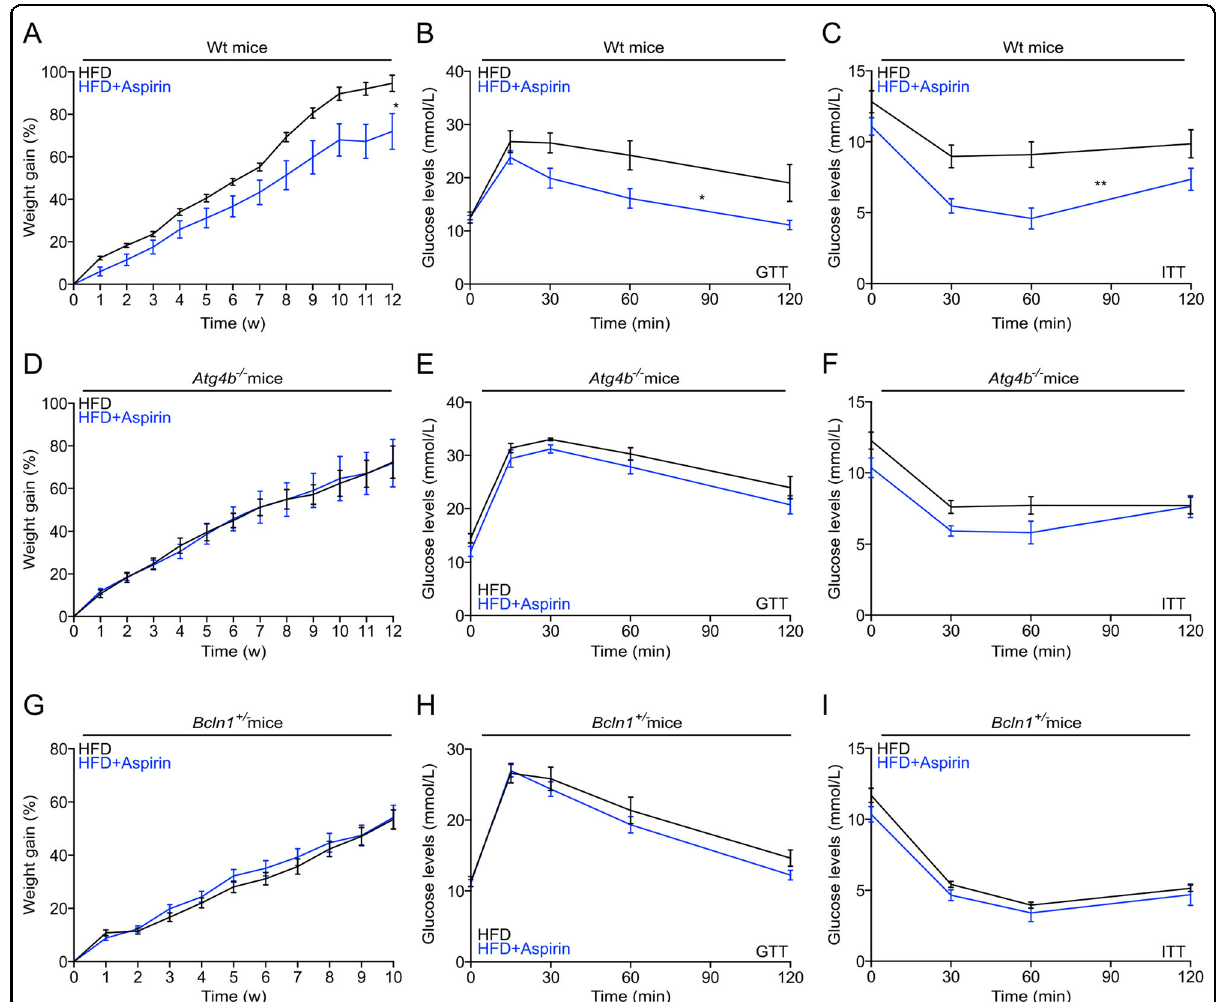
Fig. 4 Autophagy-dependent effects of aspirin on weight gain in high-fat treated mice. a , d , g Male mice with the indicated genotypes (WT, Atg4b − / − or Bcln1 + / − ) received high-fat diet (HFD) (WT mice: n = 10 mice/group; Atg4b − / − mice: Ctrl = 8 and aspirin = 9 mice; Bcln1 + / − mice: Ctrl = 17 and aspirin = 20 mice) for at least 10 weeks in presence, or not, of daily gavage aspirin administration (100 mg/kg in EBSS). Body weight was monitored weekly, and glucose ( b , e , h ) or insulin ( c , f , i ) tolerance tests were performed after 6 – 11 weeks of treatment (WT mice: GTT Ctrl = 7 and aspirin = 9 mice, ITT Ctrl = 7 and aspirin = 10 mice; Atg4b − / − mice: GTT and ITT Ctrl = 7 and aspirin = 9 mice; Bcln1 + / − mice: GTT Ctrl = 14 and aspirin = 16 mice, ITT Ctrl = 14 and aspirin = 14 mice). For statistical analysis, longitudinal statistical comparisons for mice weight gain, were performed by Wald test ( a , d , g ) (* p < 0.05); p values were determined by two-tailed unpaired Student ’ s t test (for b , e , h and c , f , i as areas under the curve (AUC) in Fig. S3A – S3C ) comparing aspirin-treated to untreated mice, (* p < 0.05, * *p < 0.01). Atg4b auto p hagy-related protein 4 homolog B, Bcln1 Beclin 1, GTT glucose tolerance test, HFD high-fat diet, min minutes, ITT insulin tolerance test, w